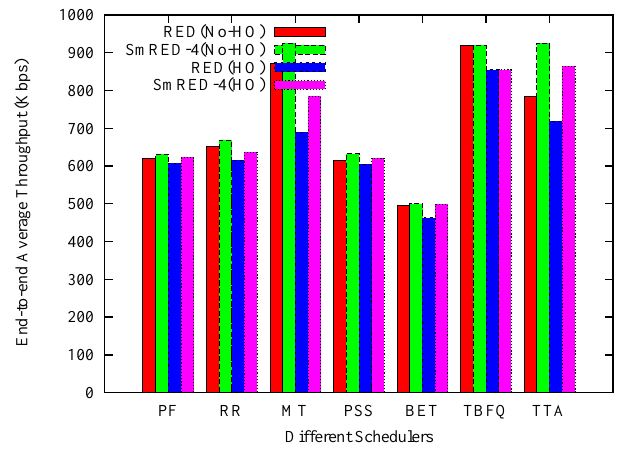
Figure 10. End-to-end average throughput of different schedulers.